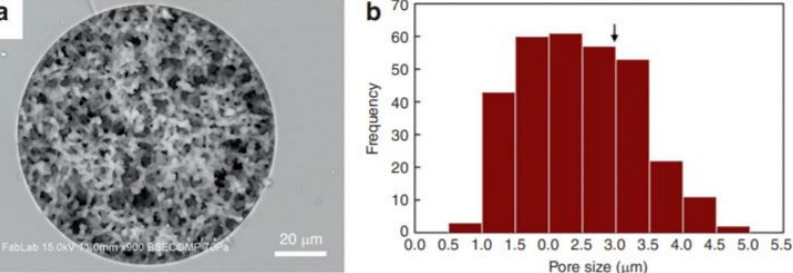
Figure 10. ( a ) Image of the silica monolith utilized in [39] for mechanical cell lysis. ( b ) Histogram of pore size. Critical diameter for RBC hemolysis is marked with an arrow.